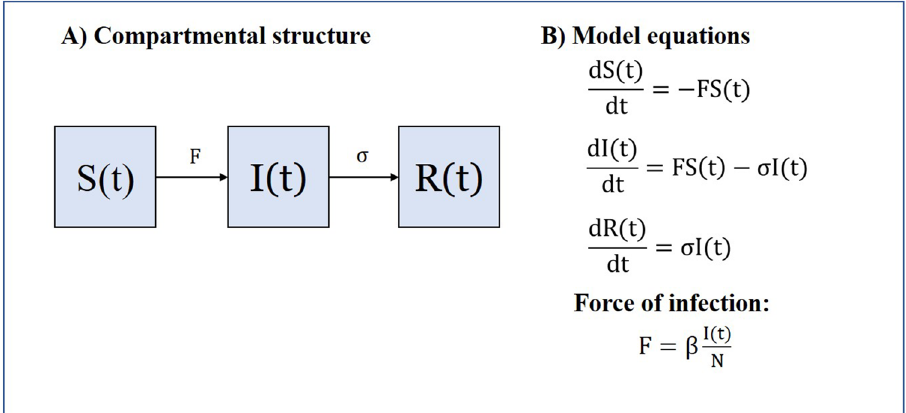
Figure 1. The compartmental structure and model equations of Kermack & Mckendrick’s SIR